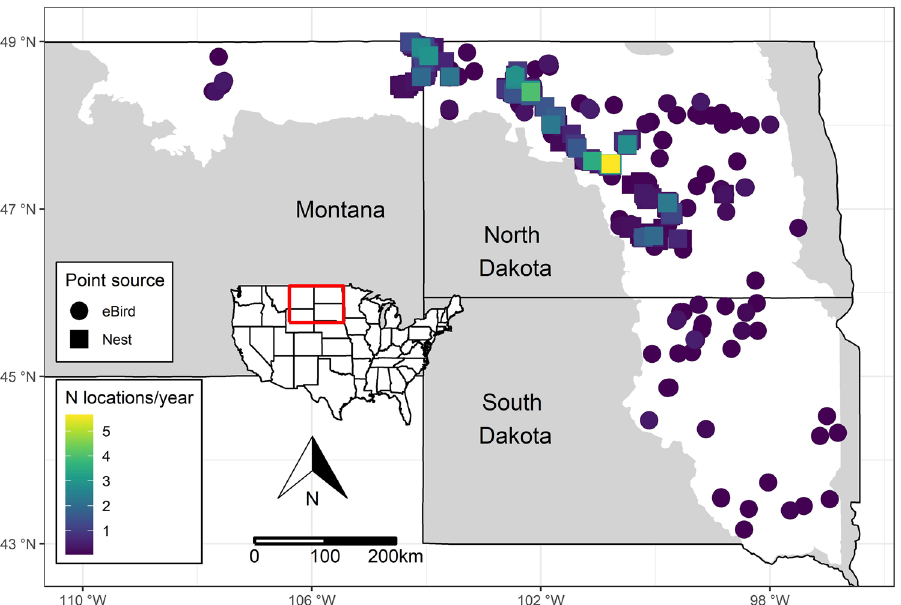
Figure 1. Study area in the north central United States including North Dakota, South Dakota, and eastern Montana. The white polygon indicates the extent of the Prairie Pothole Region included in our study. Points indicate the spatial distribution of data used from piping plover ( Charadrius melodus ) nest locations and eBird observations collected between 2000 and 2019. Each point represents a 300 m circular area and the color indicates the average number of data locations per year in each area across our study period. Maps were generated using R (version 4.1.3) 55